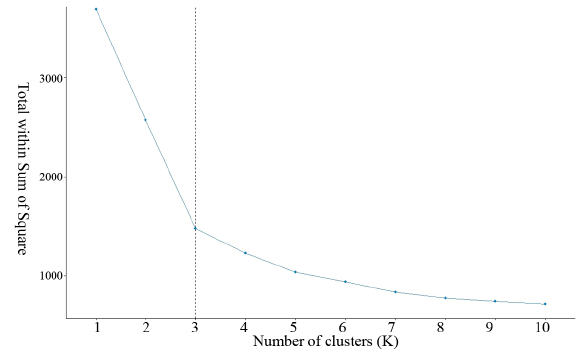
Figure 5. SEE curves for different Ks when clustering.